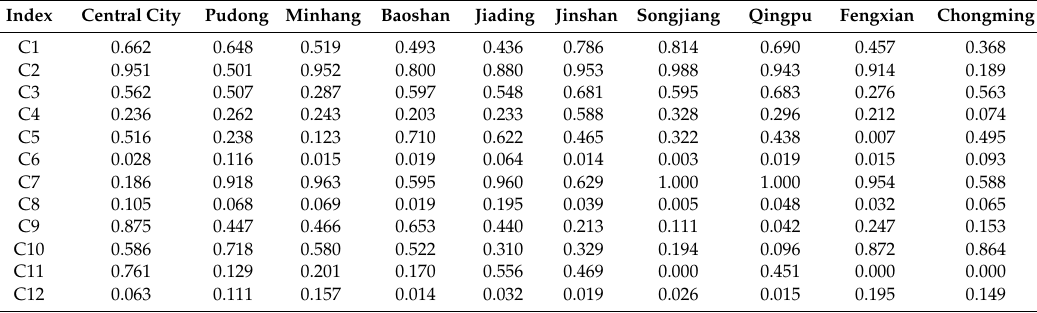
Table 9. Evaluation index values for groundwater exploitation and utilization risk in